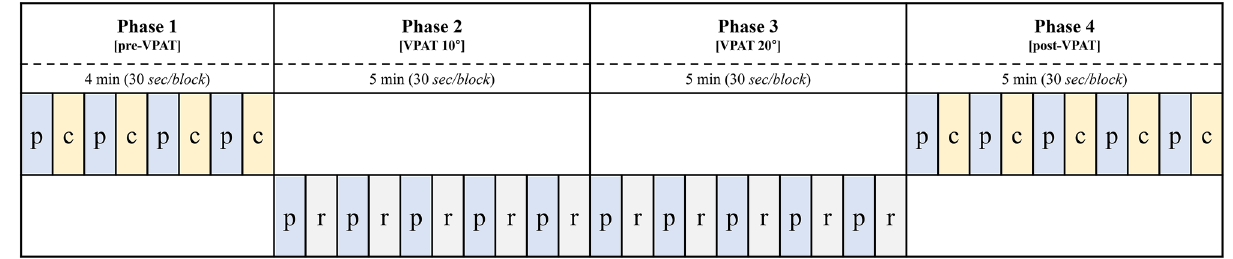
Figure 4. Experimental design. VPAT, virtual prism adaptation therapy; P pointing; C, clicking; R, point from the HMD coordinate system is p x | hmd and the point in the hand sensor coordinate system is p x | hand , the relationship is given by the following equation: